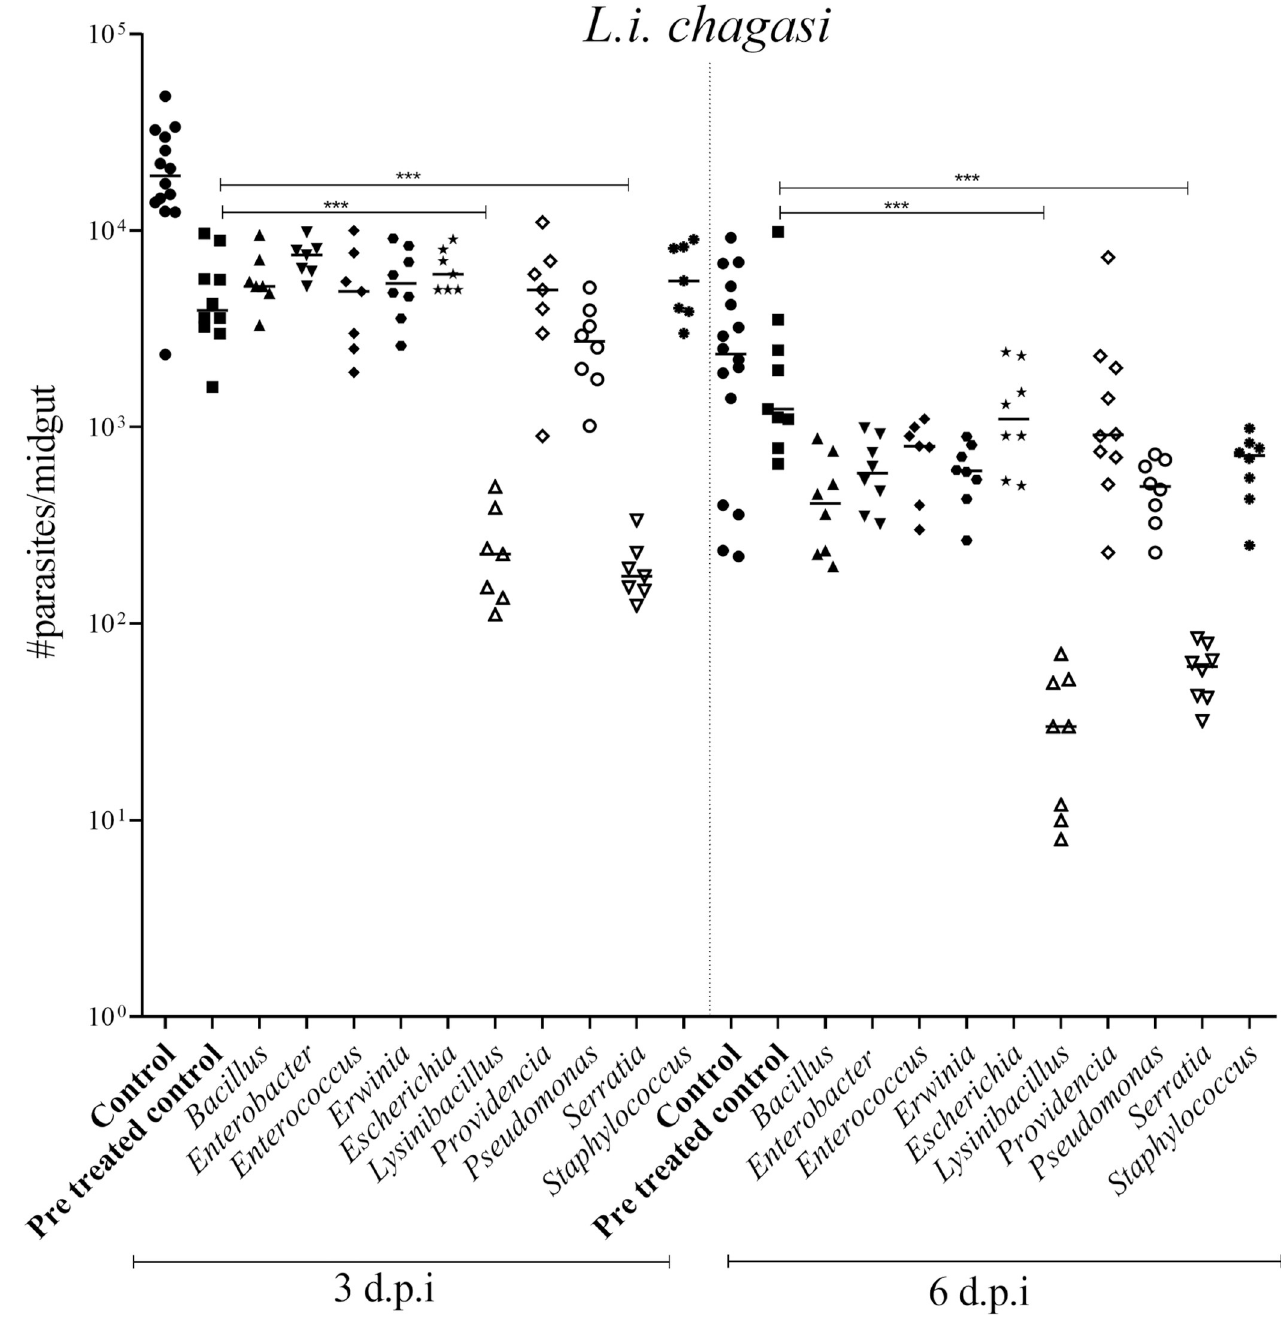
Fig 3. The effect of co-infection of L . i . chagasi and native bacteria. In vivo co-infection showing the result of the co-infection of L . i . chagasi (initial concentration 4x10 6 parasites/mL) with all ten bacterial taxa (initial concentration of 10 8 CFU/mL) isolated from Lu . longipalpis . The midguts individually macerated, and the number of parasites alive counted under a hemocytometer. The groups co-infected with Serratia and Lysinibacillus showed the lowest infection rate (statistically significant differences observed. α = 0.05). Six days post-infection, for all isolates, the number of parasites per midgut was lower than the pre-treated